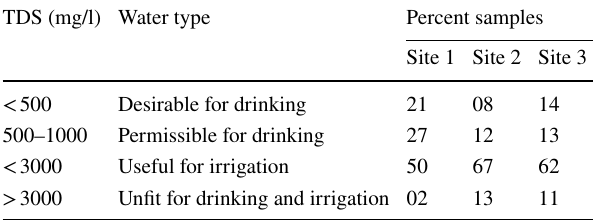
Table 5 Classification of groundwater samples based on TDS (Davis and De Wiest